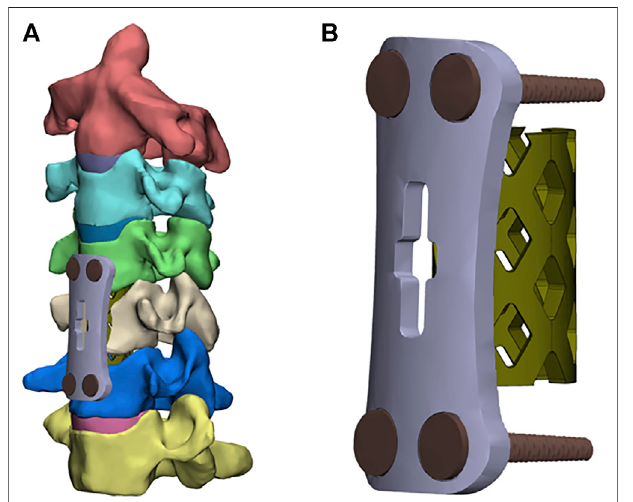
FIGURE 2 | Finite element models of the surgical procedures: (A) front view of ACCF using the TTMC; (B) the structure of the TTMC.